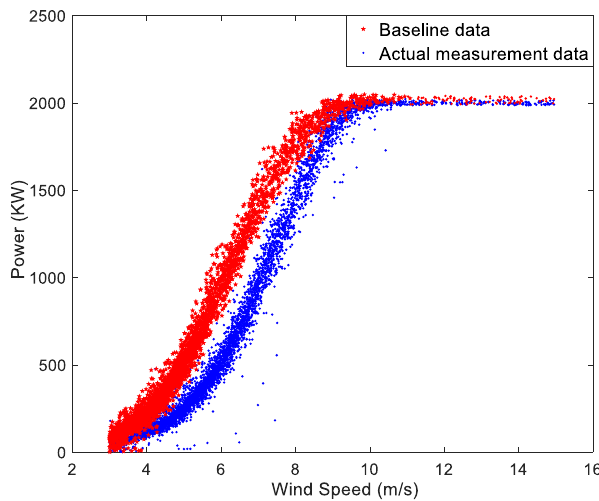
Figure 2. Baseline and actual measurement wind-power data which are cleaned.